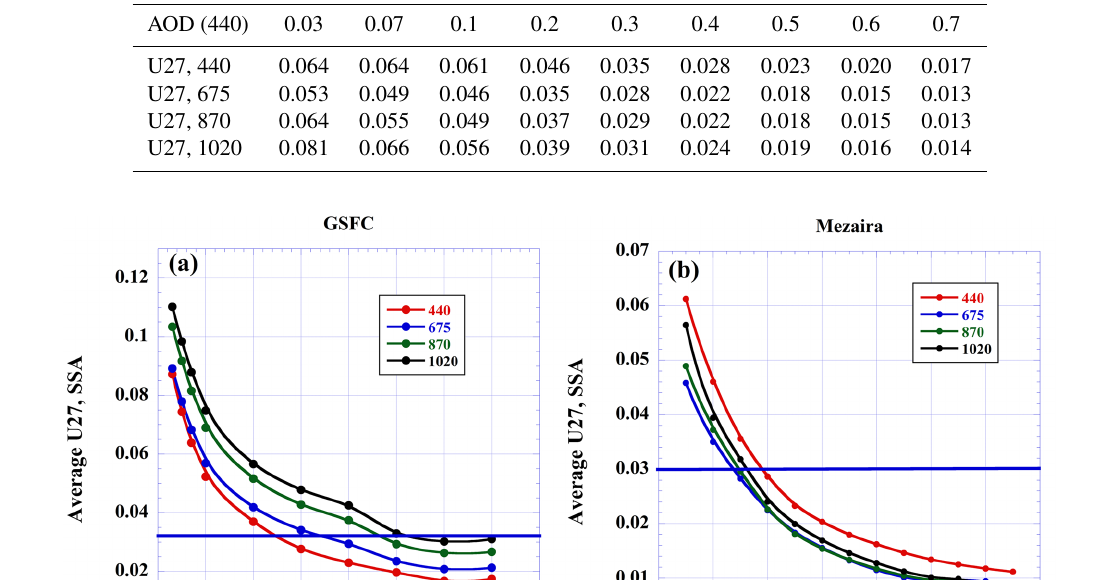
Table 15. Average SSA uncertainties estimated at Mezaira.